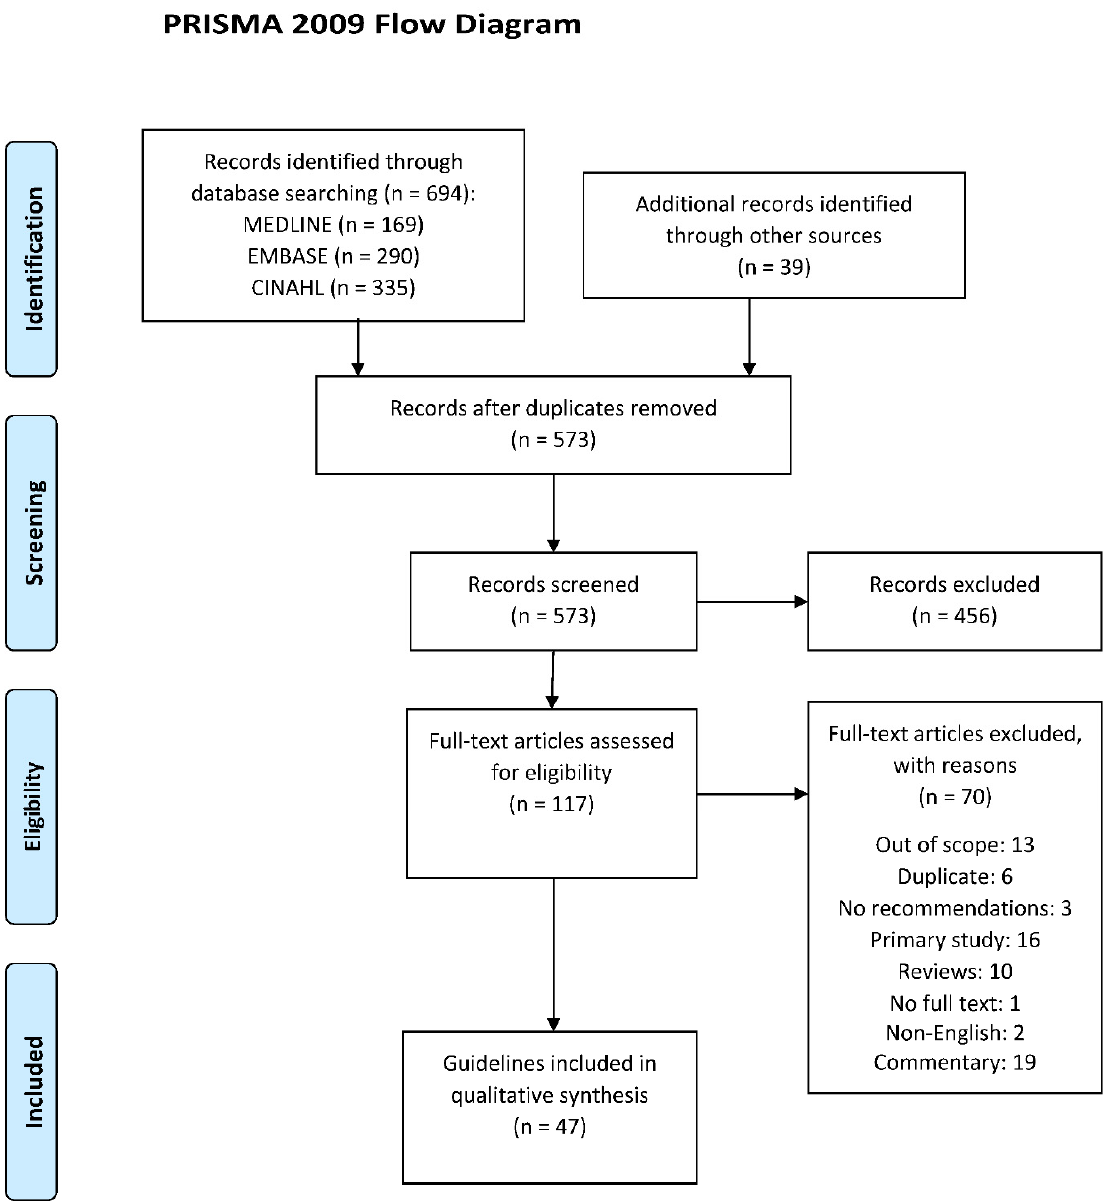
Figure 1. PRISMA to summarize guidelines/policy statements search and selection (https://guides.lib.unc.edu/prisma, accessed on 20 November